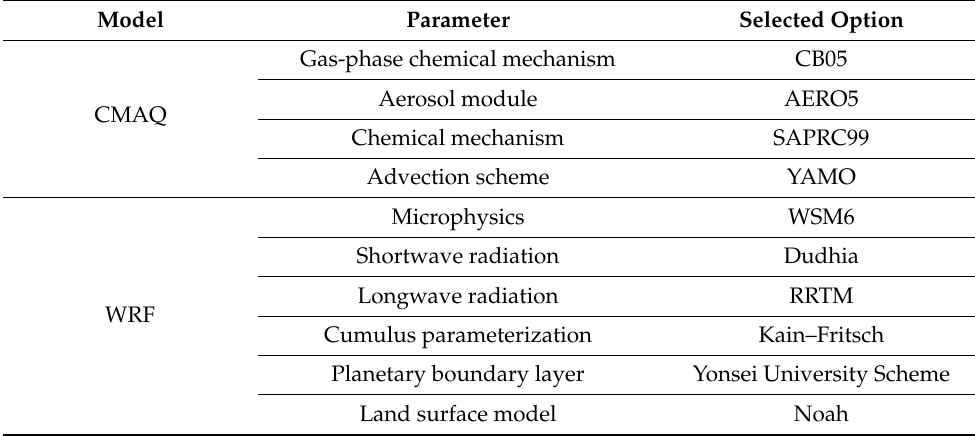
Table 4. CMAQ and WRF model